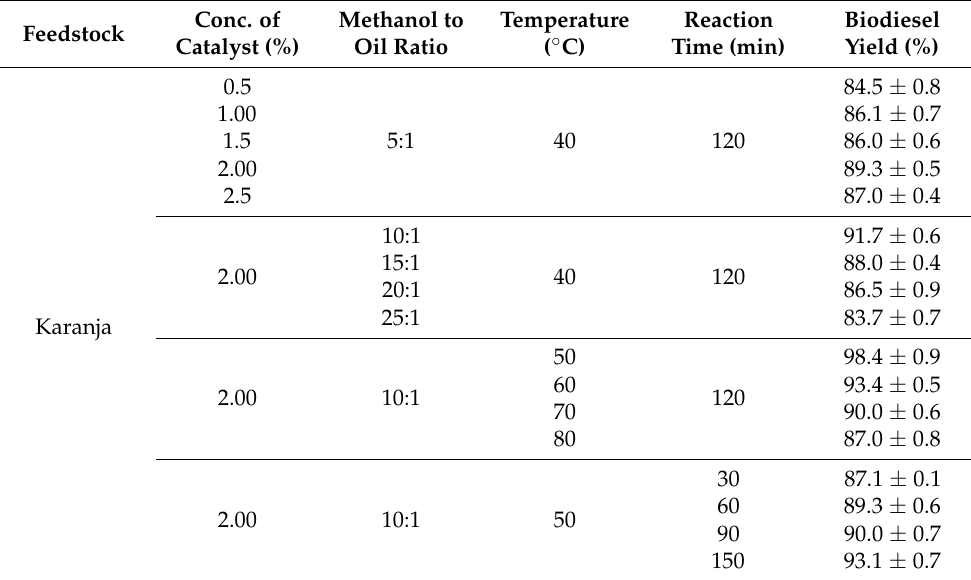
Table 3. Yield of biodiesel from karanja oil with changes in reaction parameters. Conc. of Methanol to Feedstock Catalyst (%)